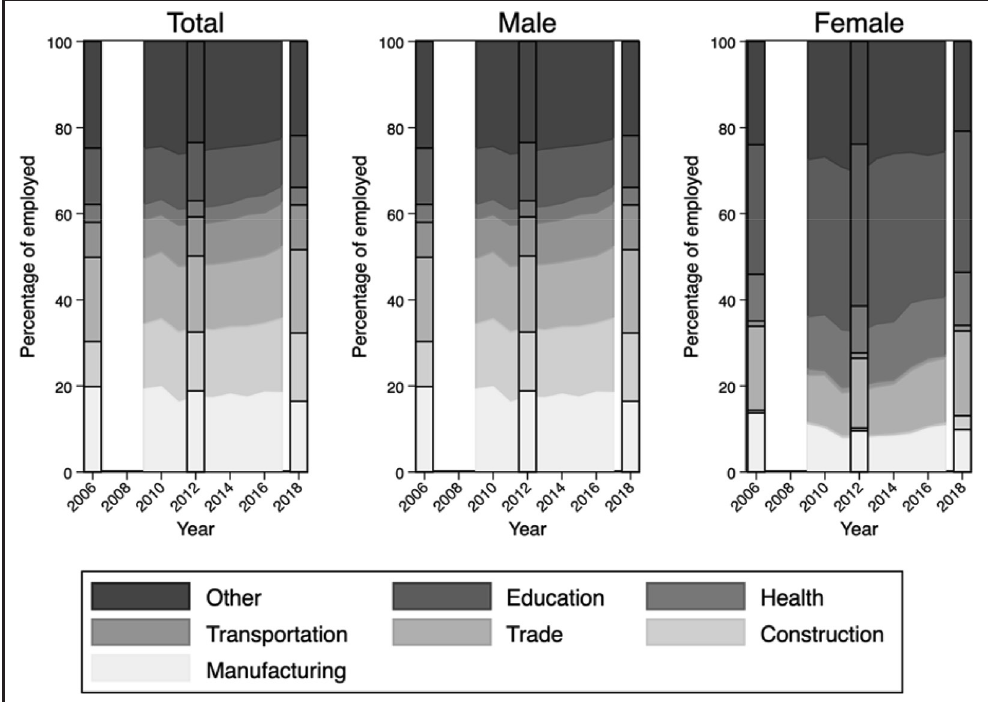
Structure of employment by industry, sex, and data source, employed, not